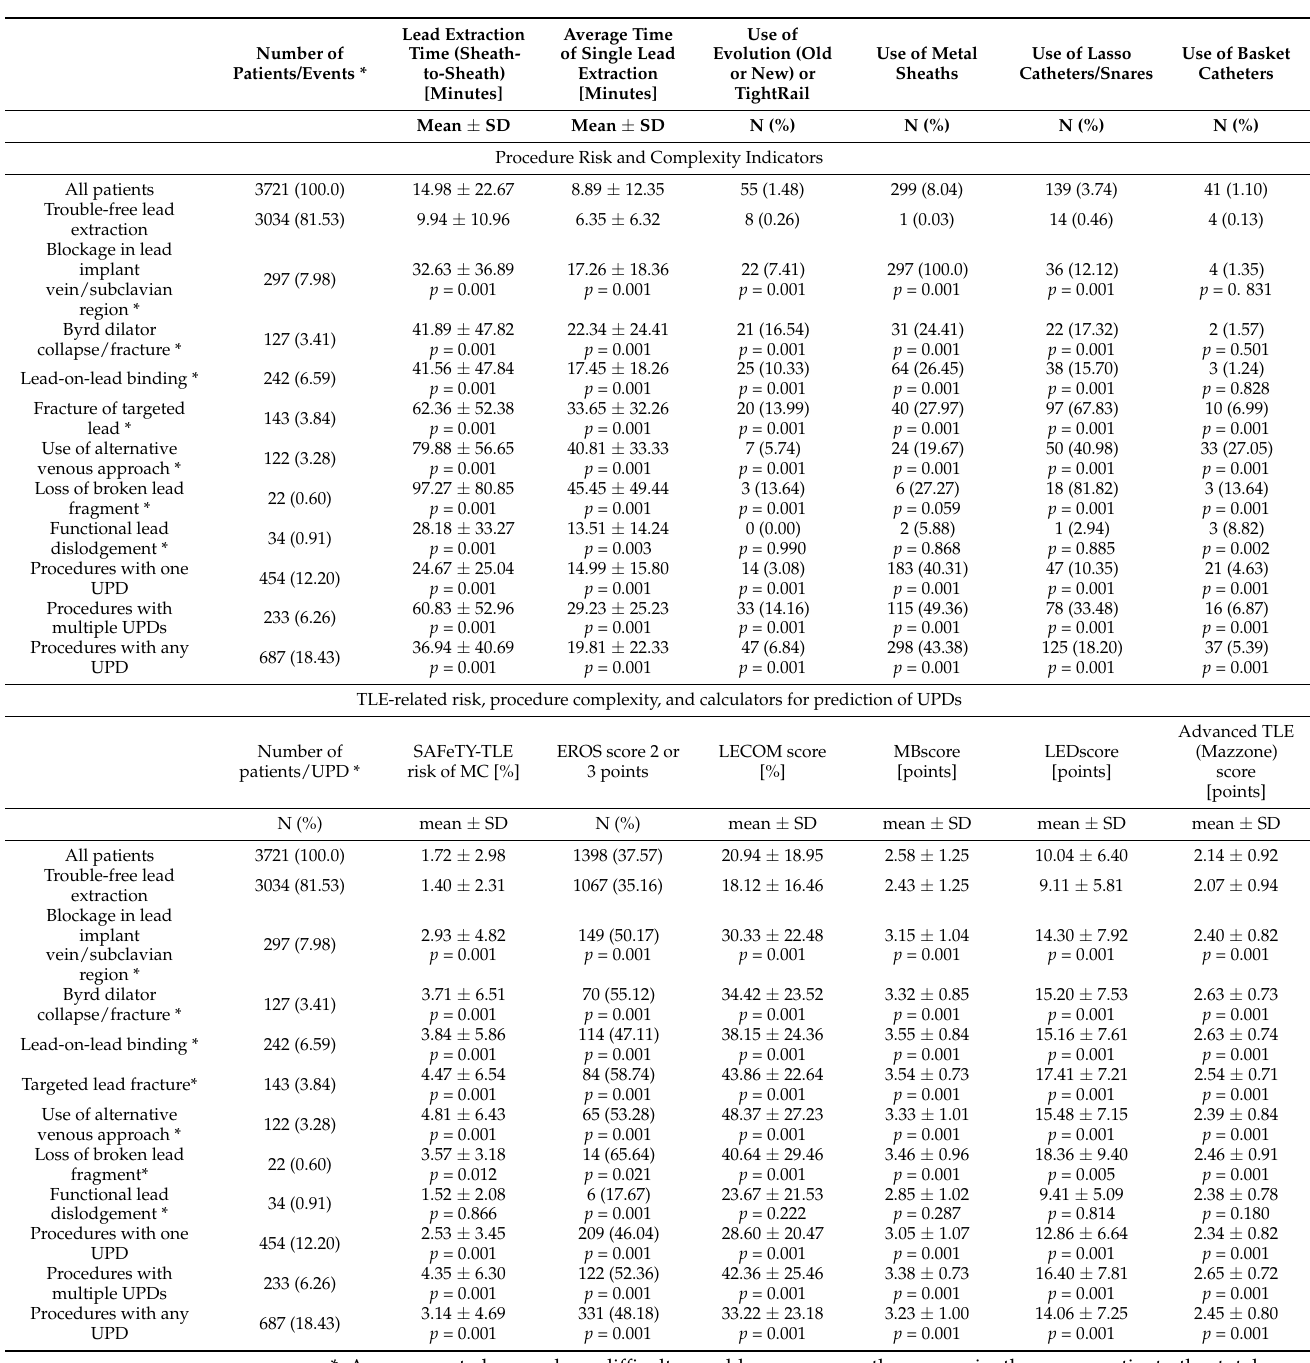
Table 4. TLE-related risk, complexity indicators and risk